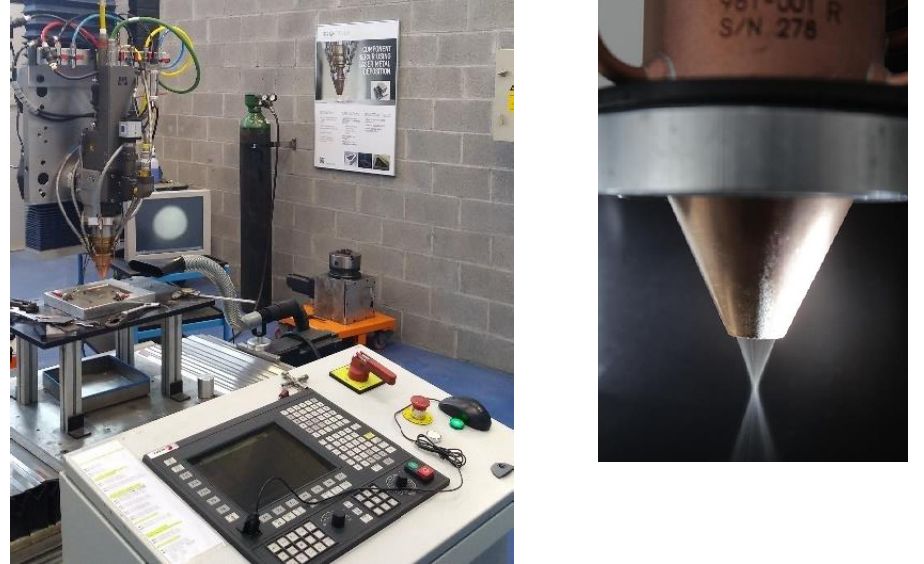
Figure 3. Cartesian kinematics LMD station in LORTEK. Detail of the station ( left ) and detail of the Coax40 nozzle with the powder flow ( right ).